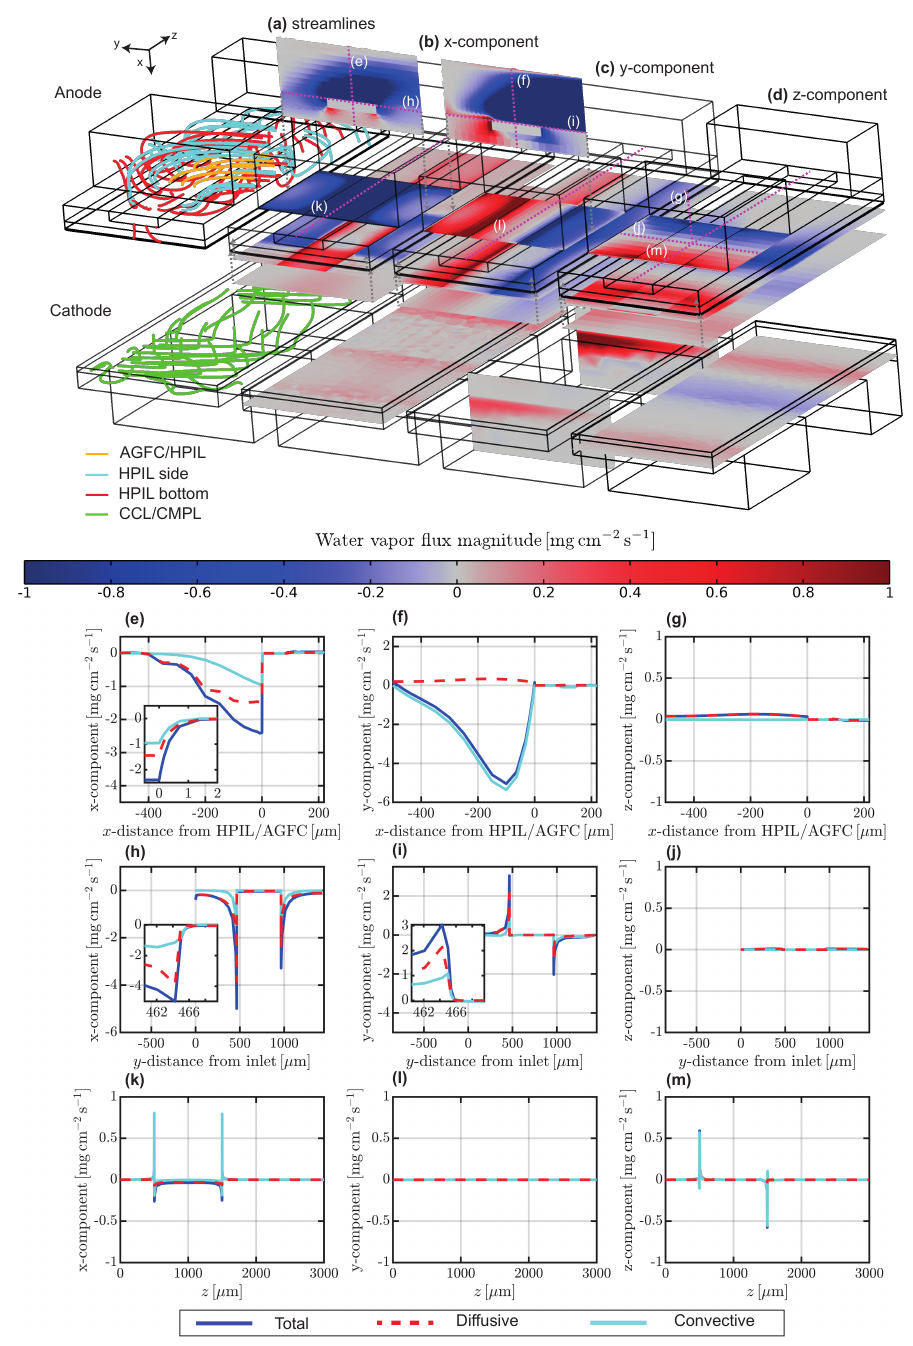
Figure 6. Base case model results: ( a ) streamlines of water vapor flux originating at different domain boundaries as indicated in the legend; total water vapor flux magnitude in ( b ) x-direction (through-plane), ( c ) y-direction (parallel to channel flow), and ( d ) z-direction (perpendicular to channel flow). ( e – m ) Profiles of water vapor flux components. Magenta dashed lines in ( a , b ) indicate each profile’s